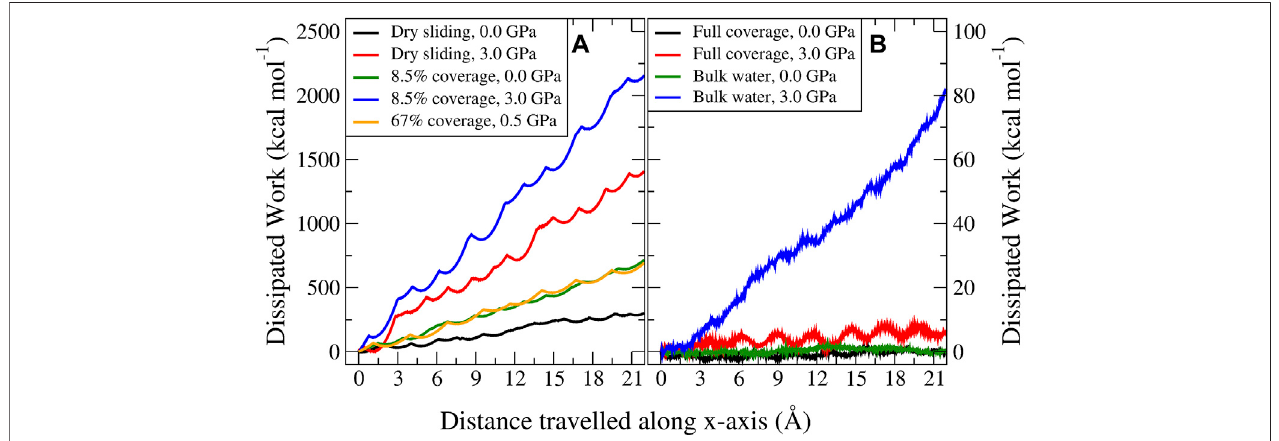
FIGURE5| Pro fi lesofthedissipatedworkforMDtrajectoriesslidinginthe x -direction.Theleftpanel (A) representsthecasefordrysliding(blackandred)and8.5% coverage (green and blue) at zero and 3.0 GPa load, respectively, and one case with 67% coverage (orange) at 0.5 GPa load which is characterized by a parallel water network.Therightpanel (B) representsthedissipationat zeroand3.0 GPaloadforfullcoverage withanantiparallelwaternetwork(black andred)andbulkwater(green and blue).